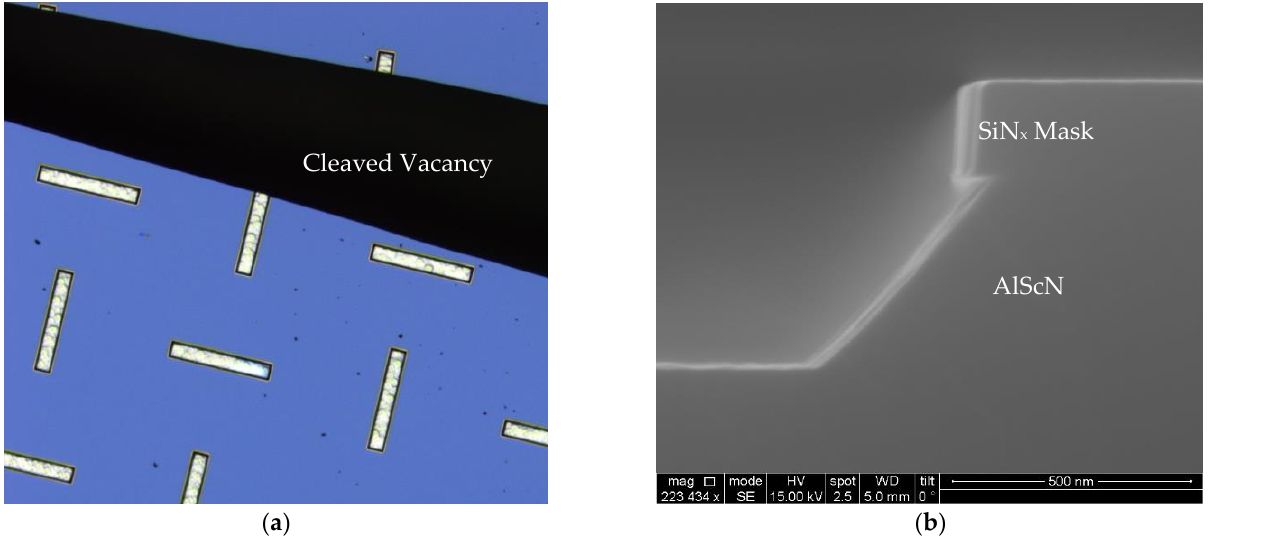
Figure 3. ( a ) A cleaved sample after etching. Black background is the vacancy after cleaving. ( b ) Cross-section SEM image of an Al 0.72 Sc 0.28 N film etched for 30 s in 30% KOH at 60 °C.